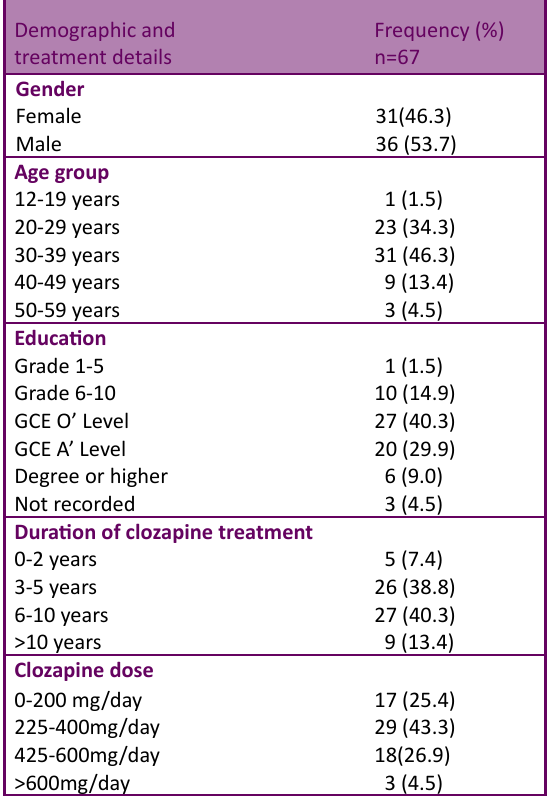
Table 1- Characteristics of the sample